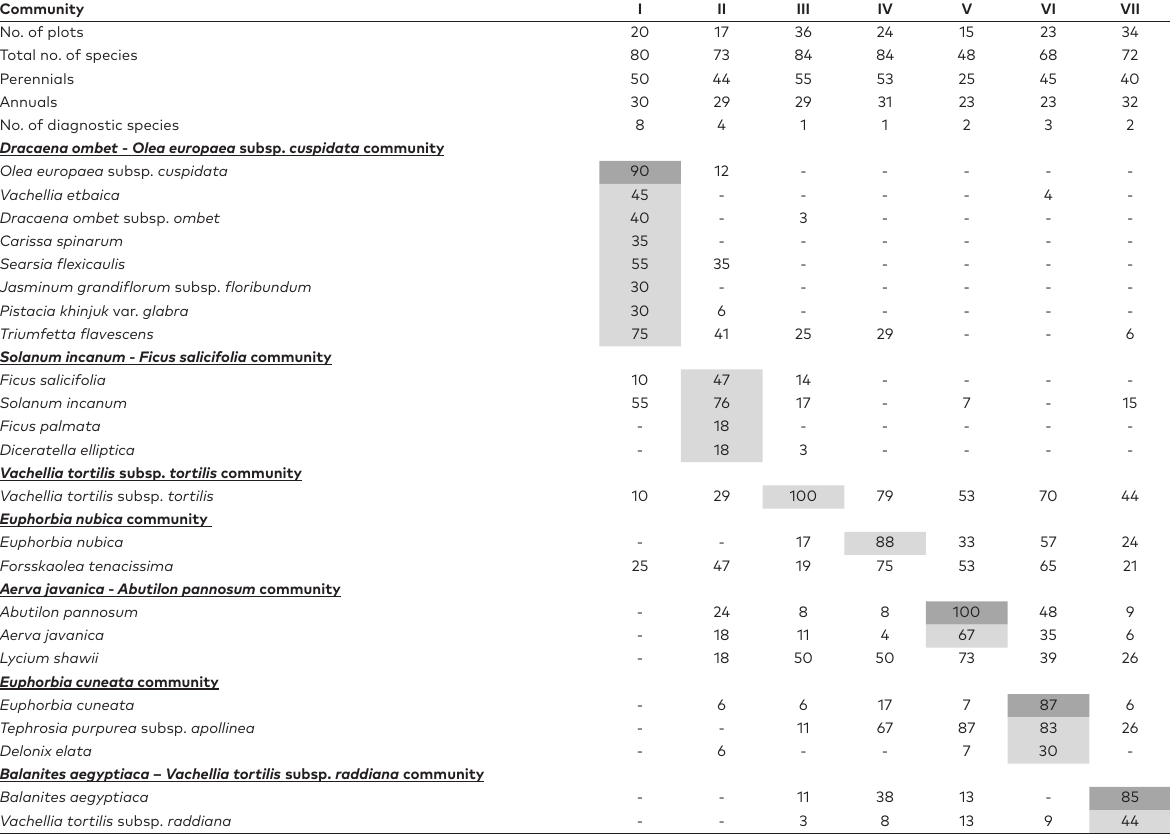
Table 1. Synoptic table of the seven communities showing percentage constancy values of the diagnostic species and non-diagnostic species with high constancy (> 70%). Diagnostic species are highlighted in light grey and highly diagnos- tic species in dark grey. Community